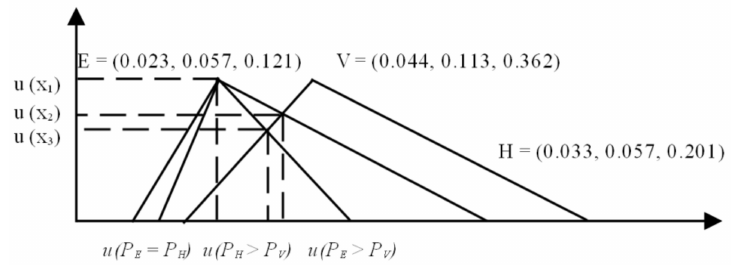
Figure 4. Triangular fuzzy affiliation of